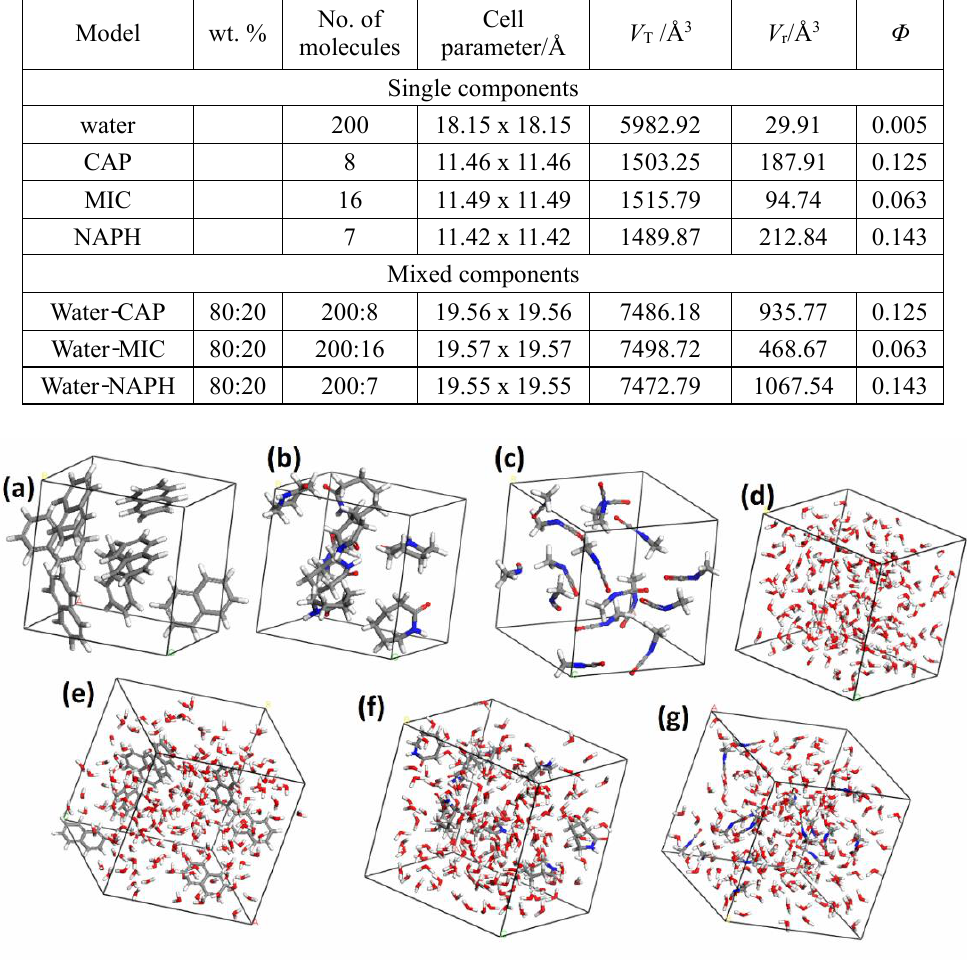
Figure 8. Models for solubility parameter calculation: a) 7 NAPH molecules, b) 8 CAP molecules, c) 16 MIC molecules, d) 200 water molecules, e) water-NAPH mixture, f) water-CAP mixture